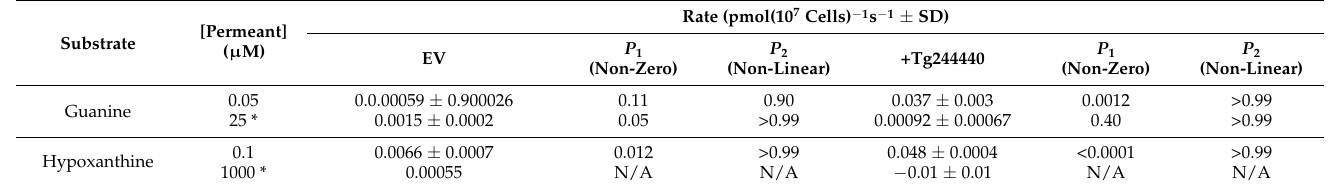
Table 1. Increase in the rate of [ 3 H]-guanine and [ 3 H]-hypoxanthine uptake in TbNBT-KO cells transfected with the empty vector (EV) or Tg244440 (clone